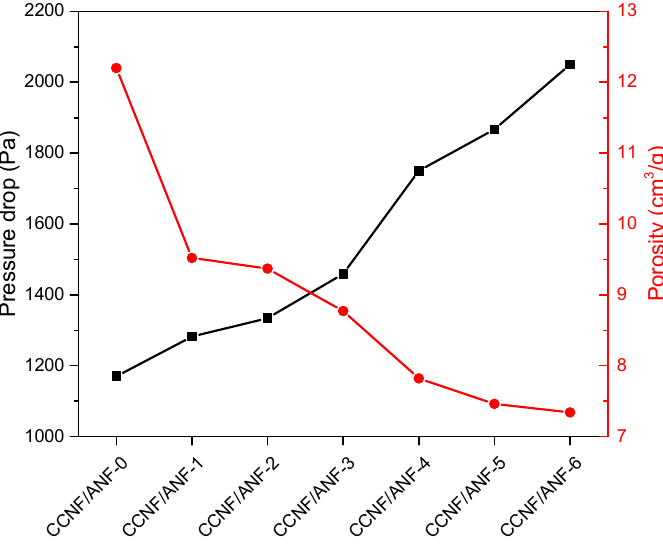
Figure 7. Pressure drop performance and porosity of different porous samples.